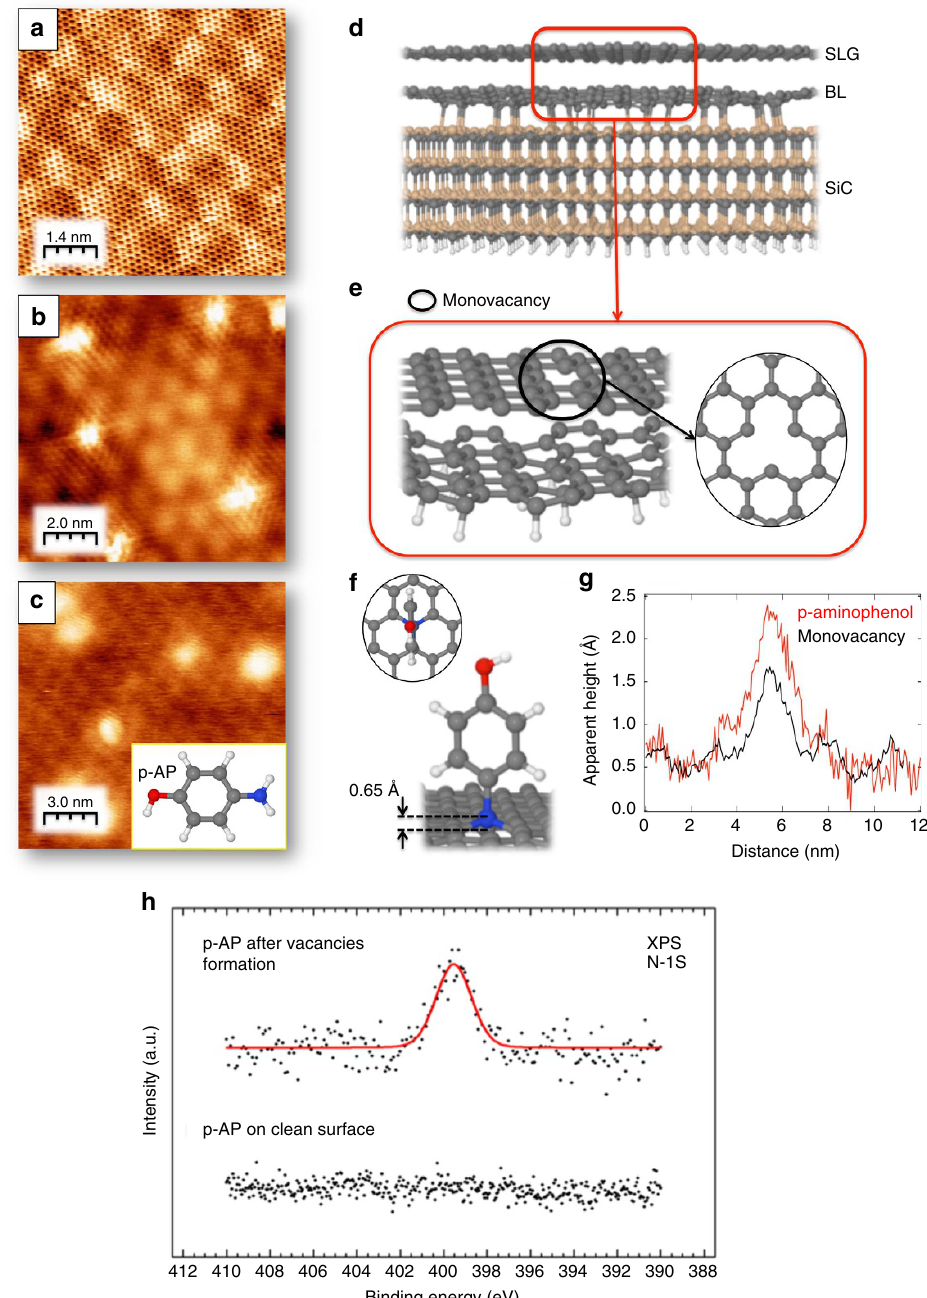
Figure 1 | Covalent link of p-AP molecules on the surface via single-vacancy formation. ( a ) Atomic-resolved STM image of the (6 O 3 (cid:3) 6 O 3)R30 (cid:2) reconstruction of the SLG epitaxially grown on SiC(0001); Tunnel current and bias are 0.36nA, (cid:2) 510.9mV, respectively. ( b ) STM image of single atom vacancies formed upon Ar þ irradiation on the surface; Tunnel current and bias are 2nA, (cid:2) 289mV, respectively. ( c ) STM image obtained after dosing the vacancies with 4L of p-AP; Tunnel current and bias are 0.09nA, (cid:2) 1,240mV, respectively. Images a and b were recorded with a H-terminated tip, whereas c, with a standard W tip. ( d ) pictorial representation of a fully relaxed model of 4H-SiC(0001) SLG/(6 O 3 (cid:3) 6 O 3)R30 (cid:2) unit cell 37 ; ( e ) top and side views of the optimized model for a single-vacancy created within a SLG on a graphene buffer layer. In this model we have saturated with hydrogen atoms the anchoring points between the graphene buffer layer and the SiC(0001) with respect to the model shown in d ; ( f ) top and side views of the optimized geometry of a doubly-dehydrogenated p-AP molecule with the nitrogen atom integrated in the SLG lattice within a monovacancy. Average perpendicular- to-the-surface distance between the nitrogen atom and the SLG is also shown. Low energy Ar-sputtering was used to create a controlled density of atomic defects on graphene lattice; ( g ) pypical STM Profiles on images b and c, along a single-atom vacancy and a p-AP anchored molecule, respectively; ( h ) N 1s core level spectra after dosing p-AP on a SLG surface without and with atomic vacancies. The N 1s binding energy corresponds to that of a C atom substitutional in the